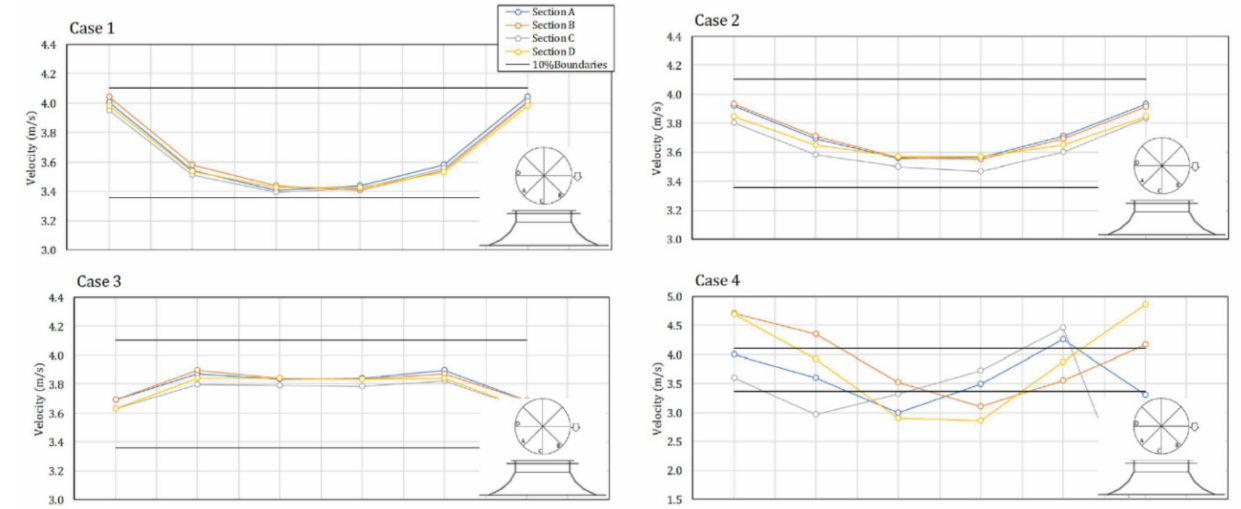
Figure 17. Point velocities at bellmouth throat.